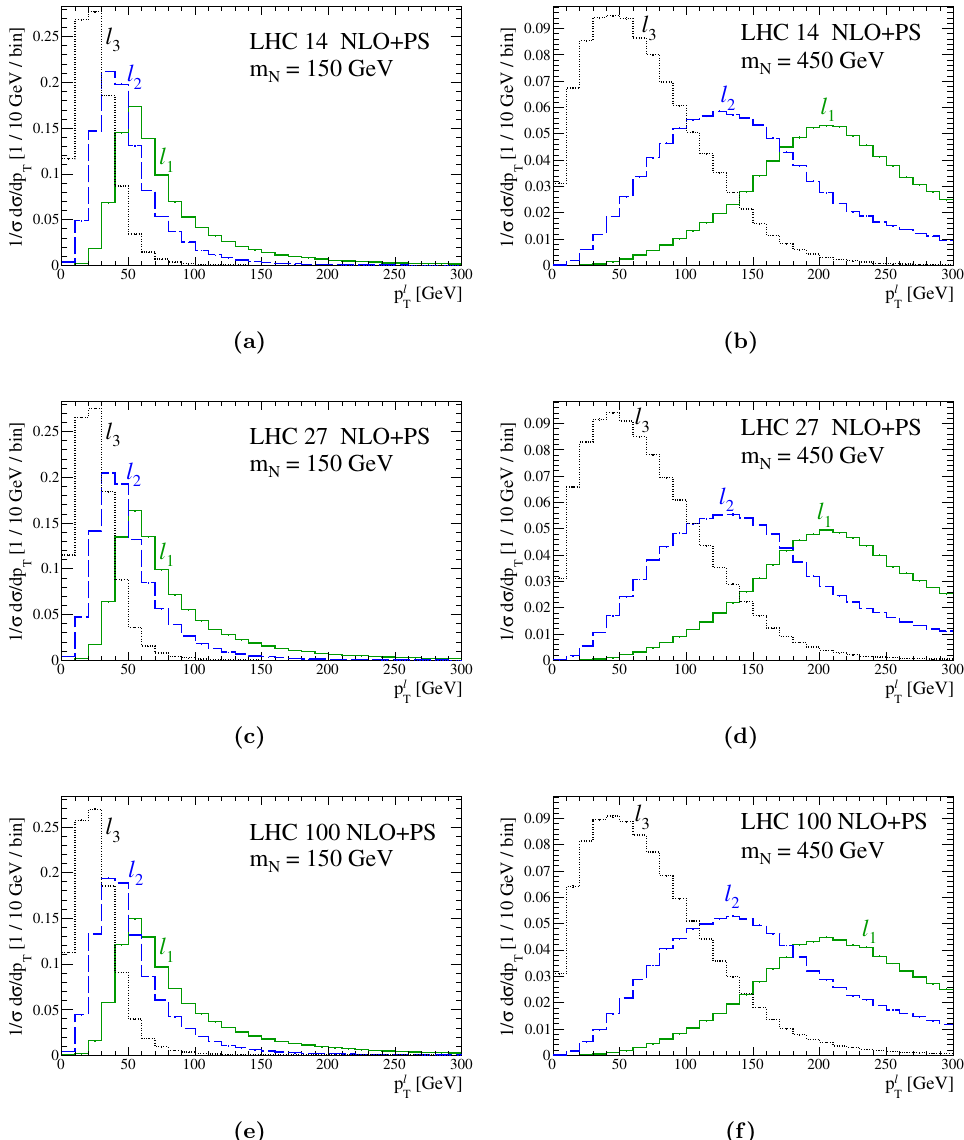
Figure 9. Same as (cid:12)gure 6 but at NLO+PS accuracy with particle-level